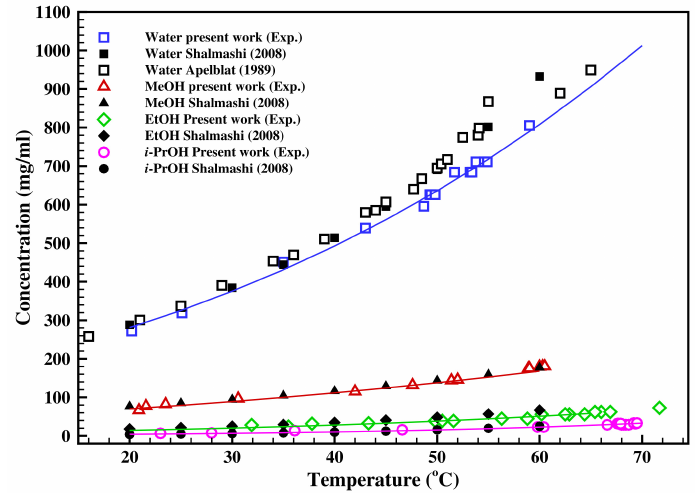
Figure 3. Experimentally measured solubility of ascorbic acid in different solvents comparison with published work [37,38]. Solid lines represents fitted solubility curves using Equation (8) in respective